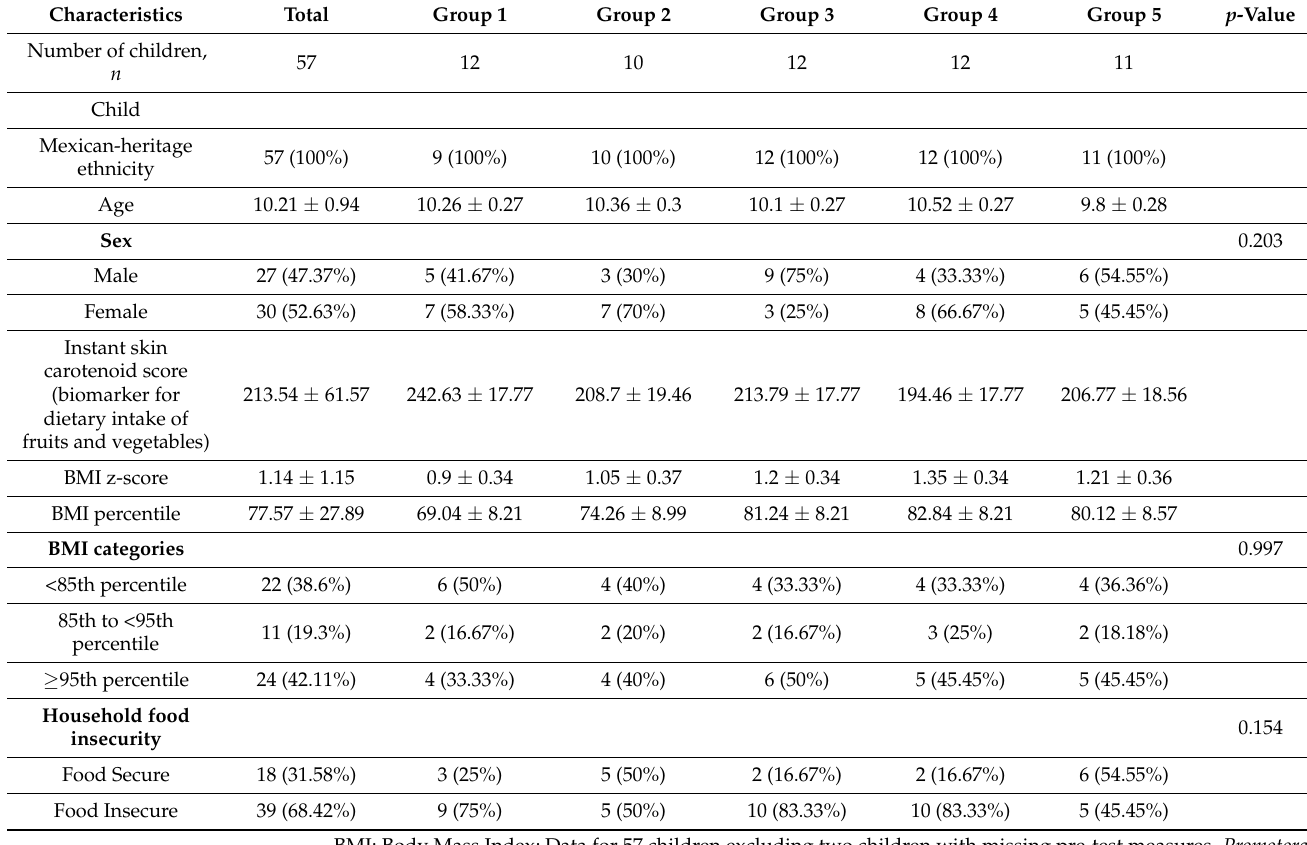
Table 1. Baseline characteristics of full sample of Mexican-heritage children in the HEPP